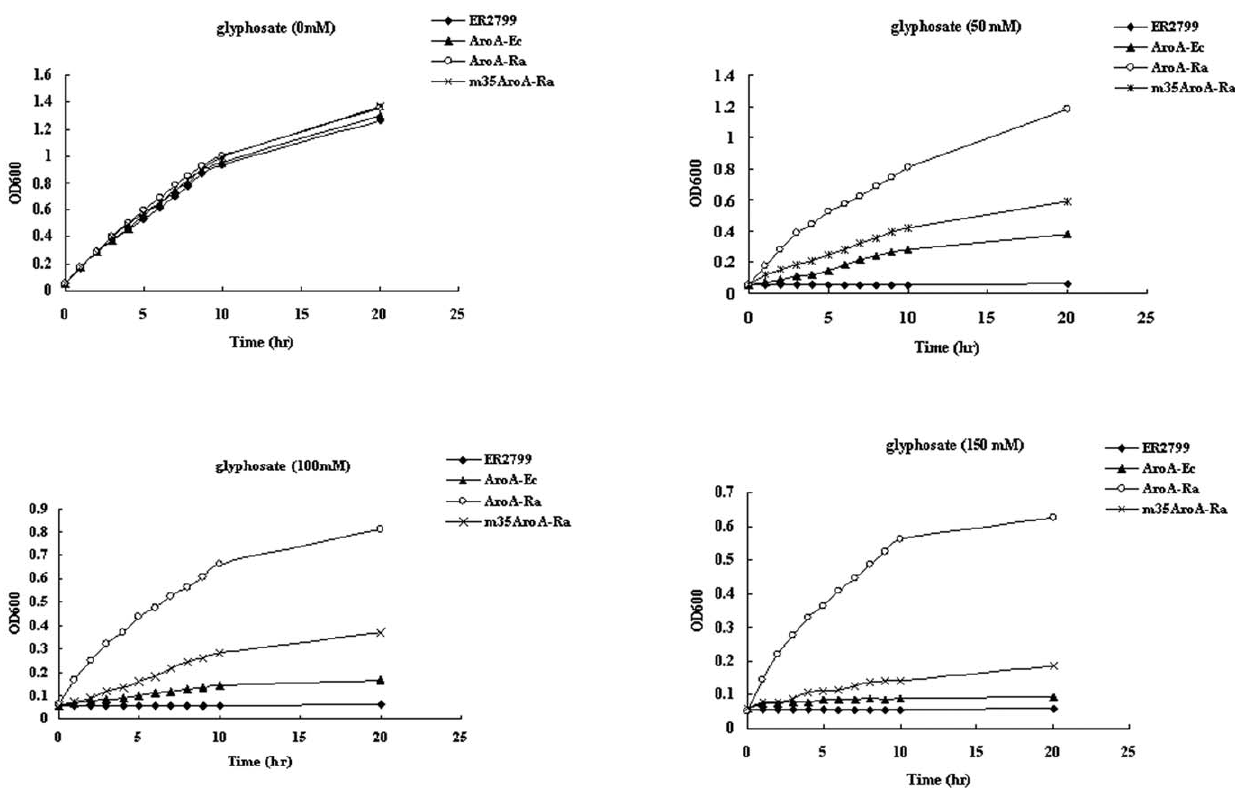
Figure 3. Growth curves of the E. coli aroA mutant strain ER2799 cells expressing AroA R.aquatilis (AroA-Ra), m35AroA R.aquatilis (m35AroA-Ra, and AroA E.coli (AroA-Ec) in liquid M9 minimal medium supplemented with glyphosate at the concentrations indicated. The results presented are the averages of two sets of experiments done in triplicate.